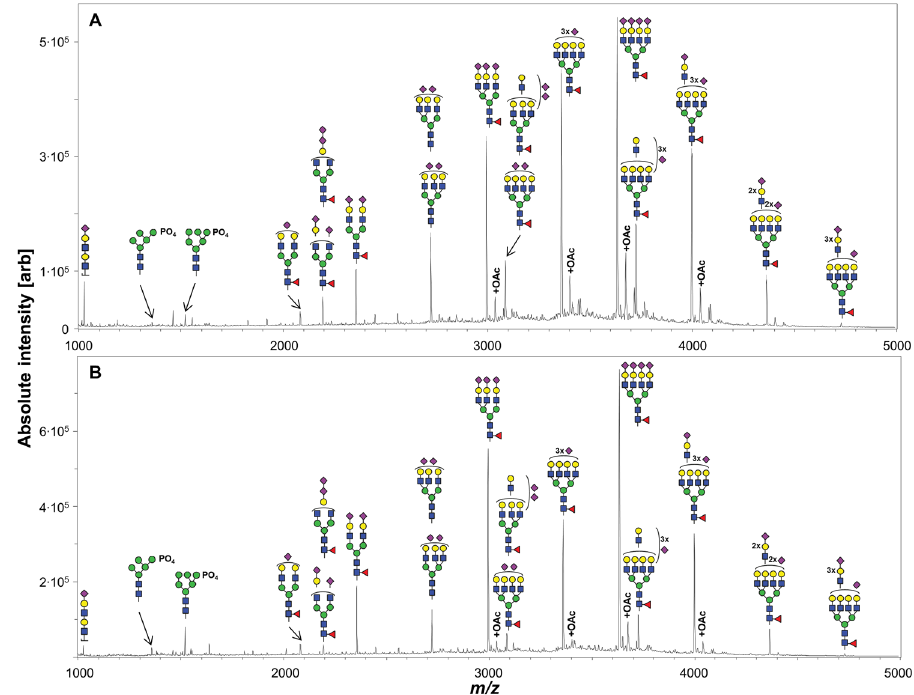
Figure 2. Representative MALDI-TOF-MS spectra of EPO N -glycans. ( A ) A spectrum of the EPO standard. It should be noted that the antenna isomerism indicated for the partially sialylated tri-antennary glycan also applies to all other tri-antennary structures. In addition, there may be minor contributions of bi-antennary structures with one LacNAc repeat. The tetra-antennary glycans have significant contributions of tri-antennary structures with one additional LacNAc repeat, as exemplified for the glycan with two NANA and 4 LacNAc units. ( B ) The major N -glycans detected for EPO purified from CCS were very similar to those of the EPO standard albeit in different relative abundances. 2 × and 3 × gives the incidence of the monosaccharide or antenna to the right or below. The brackets signify that the exact positions of substituents are unclear. The N - acetylneuraminic acids to the right of the vertical brackets may cap an antenna or